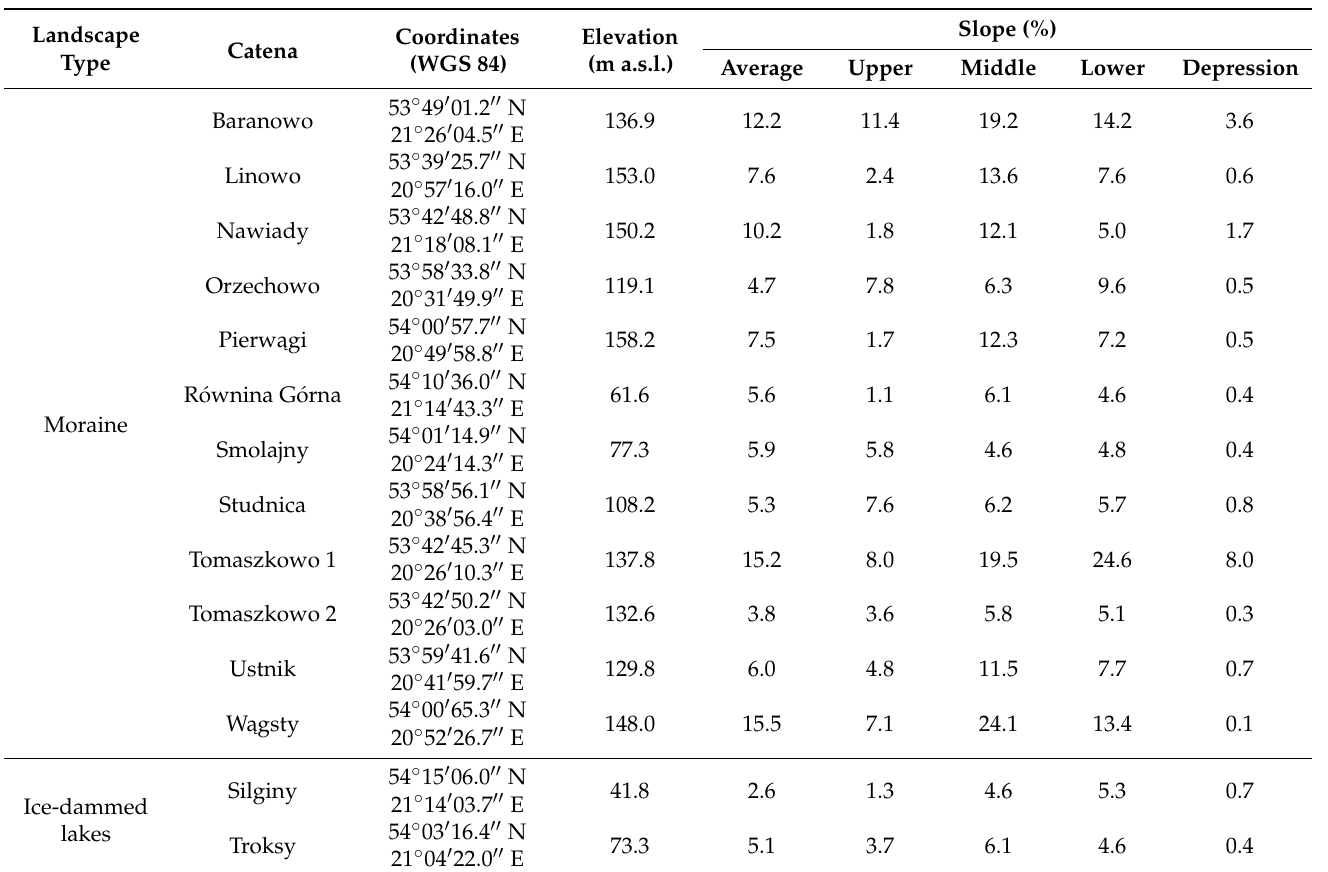
Table 1. Coordinates, elevation and slope of soil